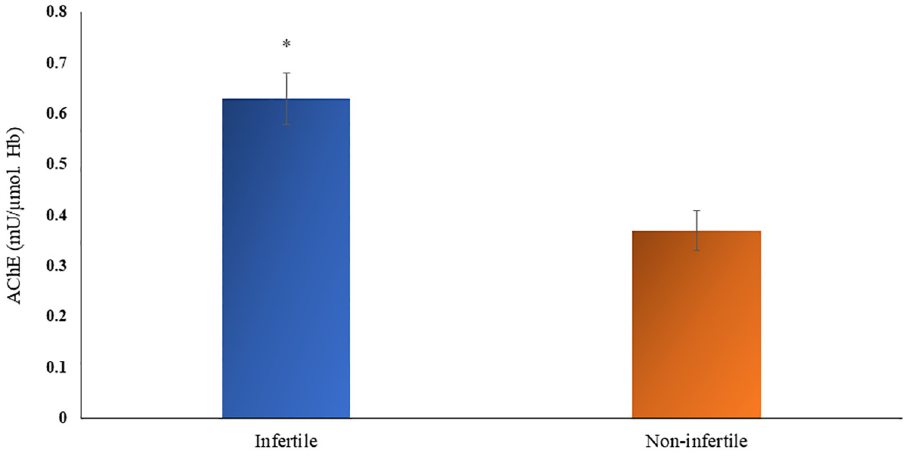
Fig 2. Activity of acetylcholinesterase in infertile and non-infertile groups, ( * significant at p < 0.05).